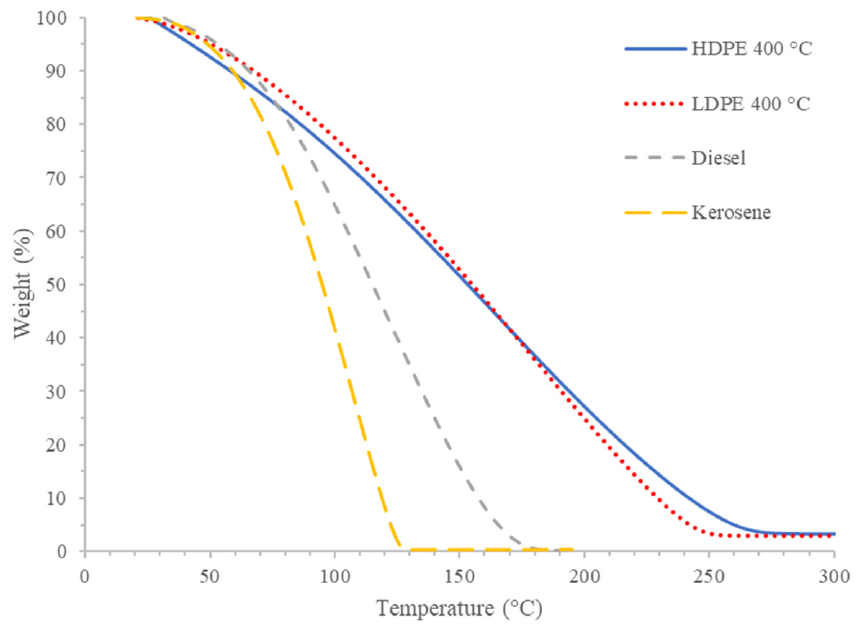
Figure 6. Representative TGA thermograms of PDFO at 370 ◦ C ( top ) and 400 ◦ C ( bottom ) with diesel and kerosene.